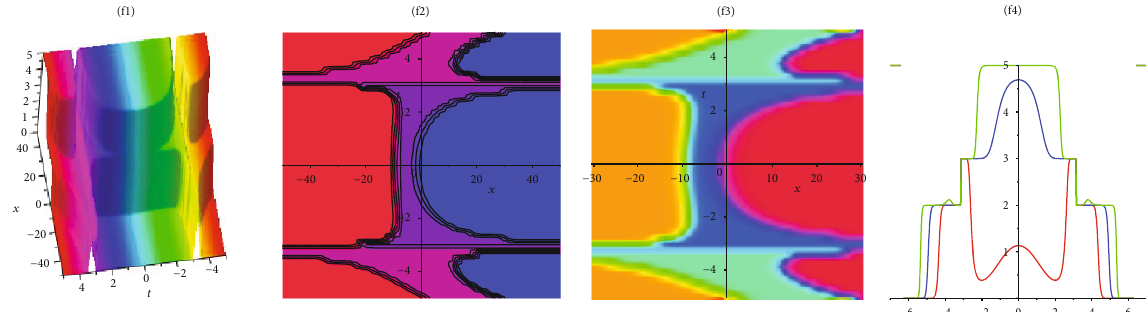
= 1, α = 1 : 5, β = 1 : 5, β = 2, σ = 1 : 1, σ = 2, ρ = 2 : 2, ρ = 3, g ð t Þ = sin ð t Þ , 1 2 1 2 1 2 1 2